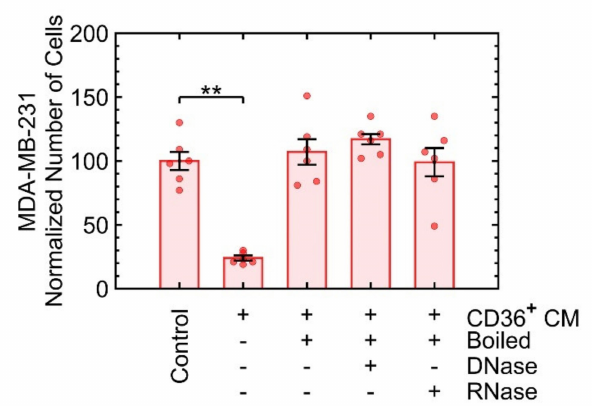
Figure 4. The heat inactivation assay coupled with the enzymatic treatment of the CM of CD36 + FBs indicates that proteins are likely to be involved in growth suppression. The cell count, on day 7, was quantified as a result of exposure to the boiled CM (i) by itself (third bar from right), (ii) with DNase, and (iii) with RNase. ** p < 0.001.